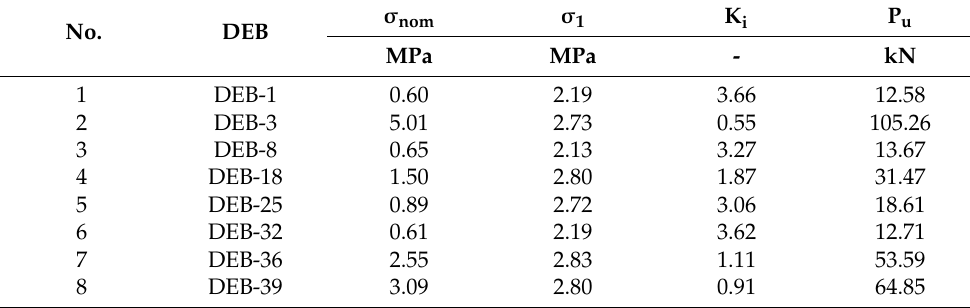
Table 4. The stresses and SCF of RC-DEBs based on RSG-A data.